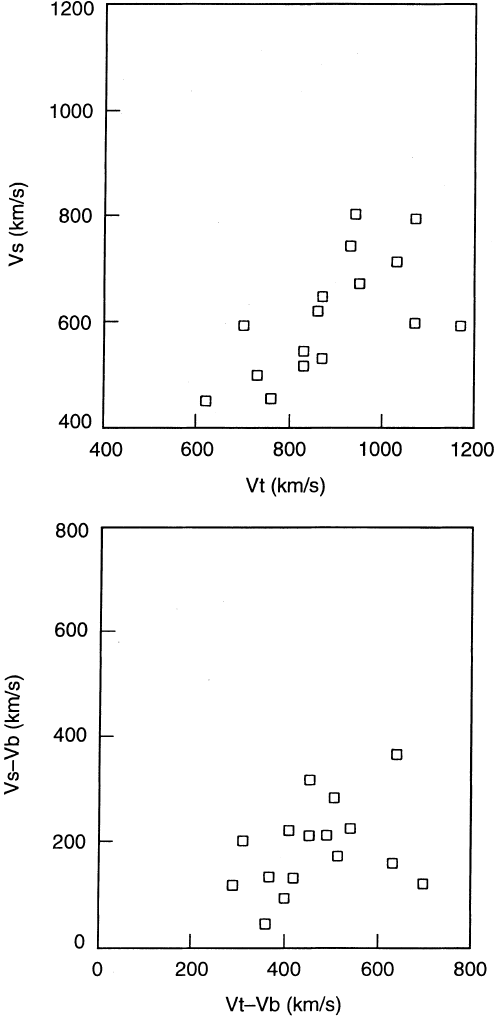
Fig. 1. Scatter plots of Vs versus Vt ( upper panel ) and ( Vs (cid:255) Vb ) versus ( Vt (cid:255) Vb ) ( lower